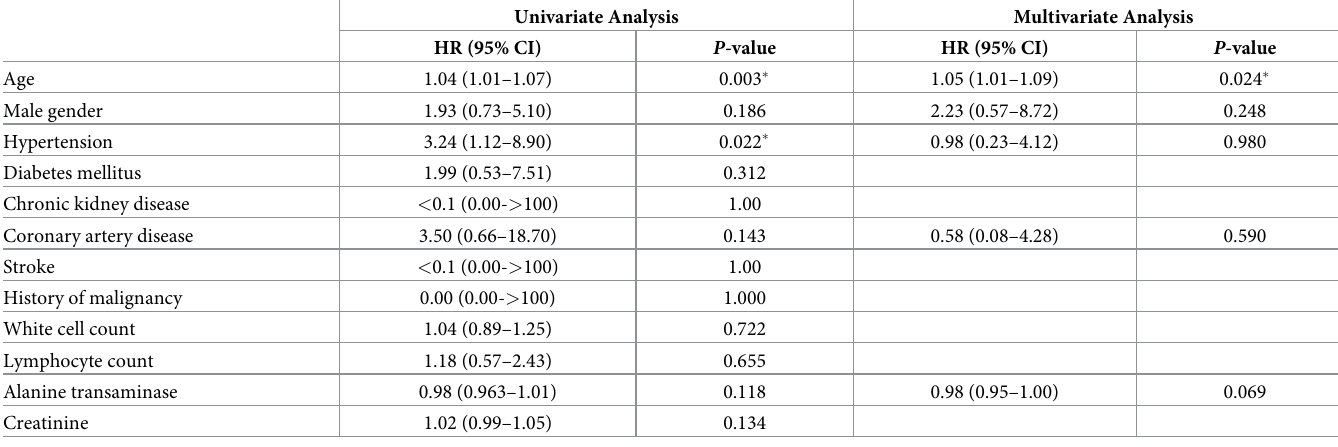
Table 4. Factors for newly detected cardiac